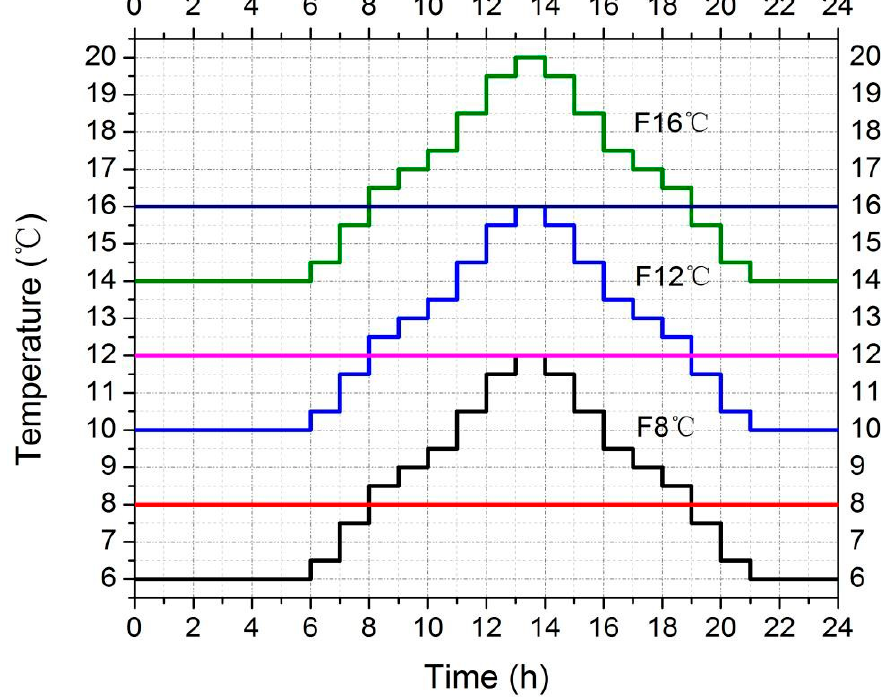
Figure 1. Fluctuating temperatures models.